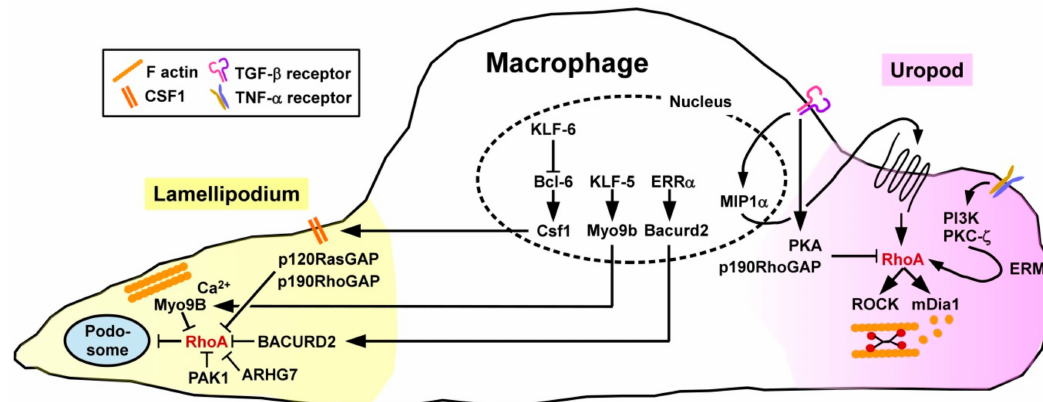
Figure 3. Migration of MAC requires spatially controlled activation of RhoA. At the migration front various GAP (e.g., Myo9B, p120RasGAP) and other factors (e.g., BACURD2) that inhibit RhoA activity. Endopeptidases concentrated in podosomes mediate dissociation of the ECM which is necessary for MAC migration. Podosome formation is inhibited by RhoA. At the rear end RhoA activity is required for uropod retraction. RhoA is activated, e.g., by TNF- α via PI3K / PKC-. ζ signaling resulting in activation of ERM which, in turn, translocate RhoA to the membrane. TGF- β first promotes RhoA activity via an autocrine MIP-1 α stimulation loop, but at later time points inhibits RhoA via PKA signaling and